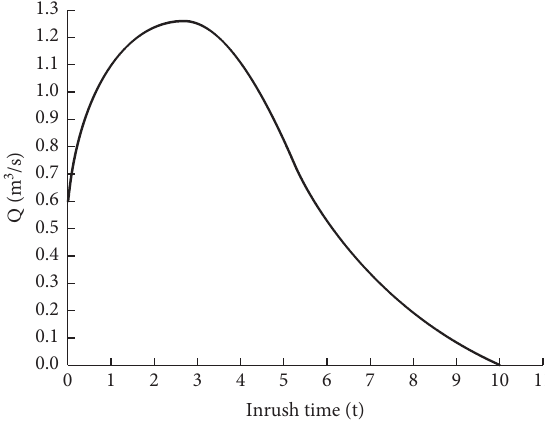
Figure 15: The evolution law of water discharge in the roadway during the process of water